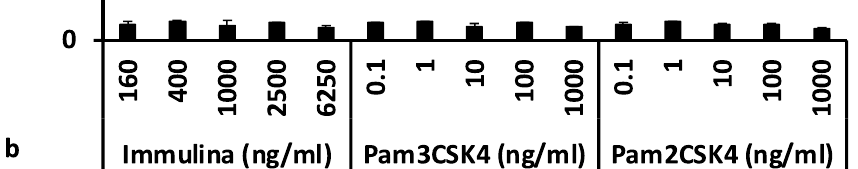
Figure 3. Immulina extract activates the TLR2/TLR1 signaling pathway. Activity evaluated in HEK-Blue hTLR2-TLR1 cells ( a ) and control HEK-Blue hTLR2 KO-TLR1/6 cells ( b ). Response ratio ± SD is defined as OD of sample/OD of untreated cells. Synthetic triacylated lipopeptide Pam 3 CSK 4 was used as a positive control, and the synthetic diacylated lipopeptide Pam 2 CSK 4 served as the negative